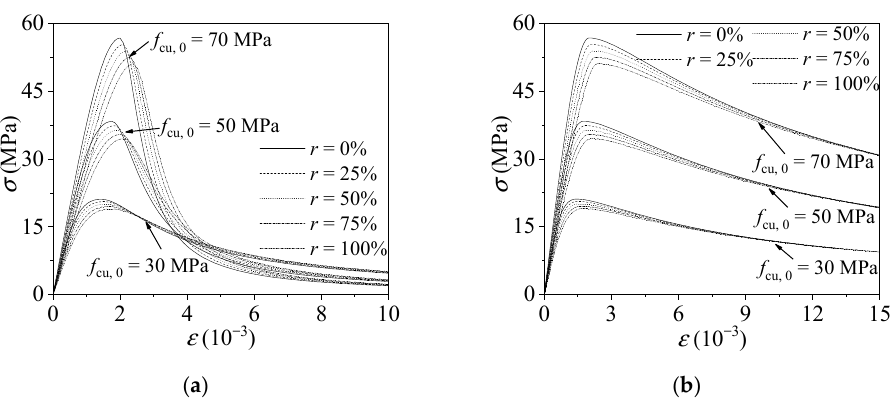
Figure 3. Diagram of confined and unconfined plastic-damage model of RAC: ( a ) unconfined strain–stress relation of RAC with different replacement ratio; ( b ) confined stress–strain relation of RAC with different replacement ratio.